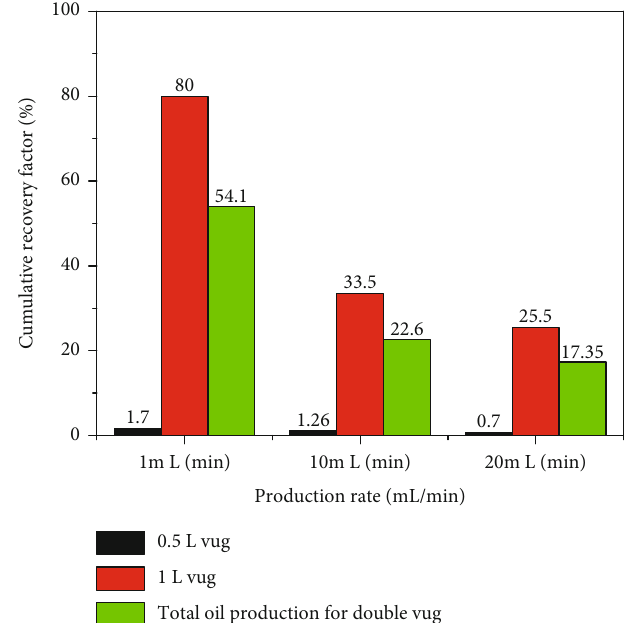
Figure 15: Column chart of crude oil recovery percent in high-pressure physical property experiments under connection type I (di ff erent production